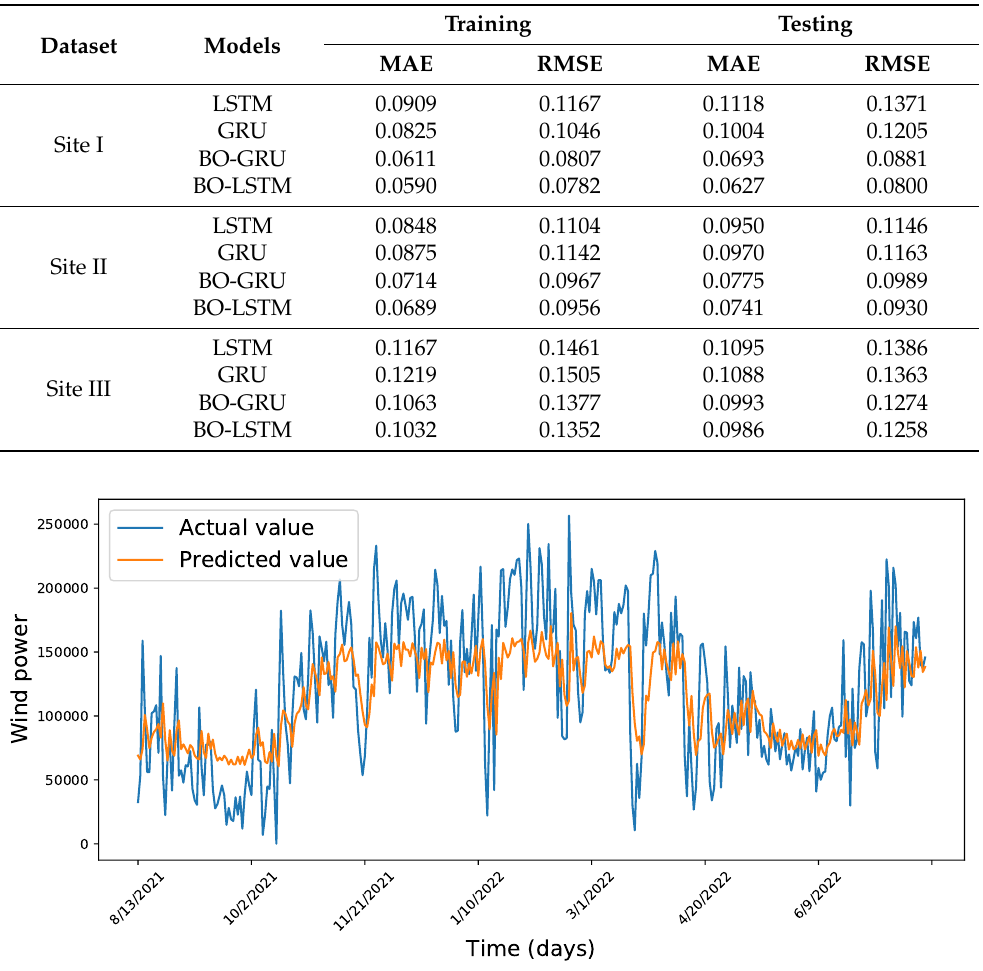
Figure 10. Prediction vs. actual plot for Site I.